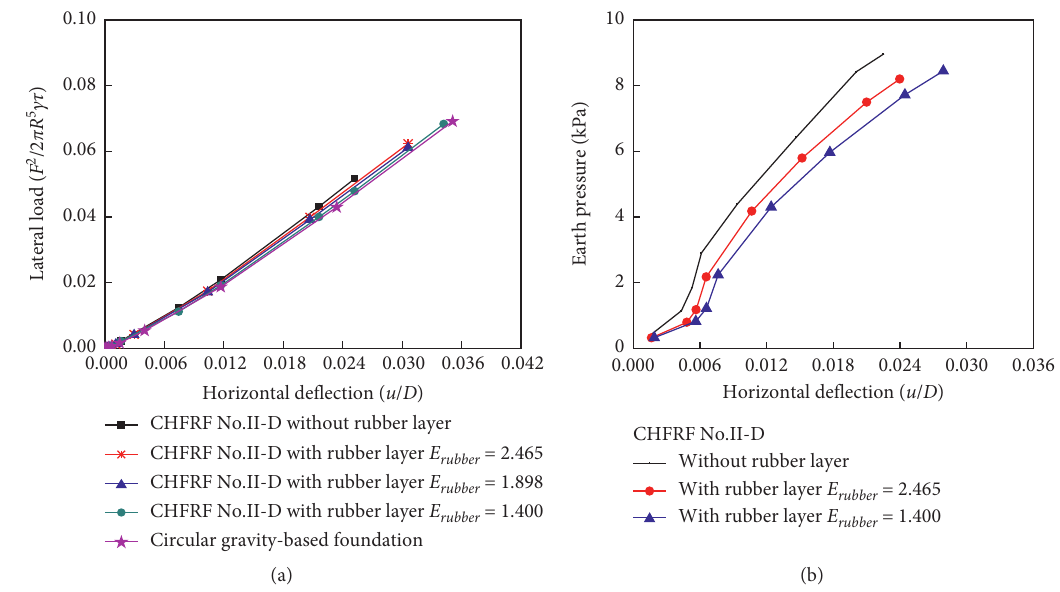
Figure 15: Effects of a rubber layer on the lateral bearing behaviors. (a) Lateral load versus deflection. (b) Earth pressure versus deflection.